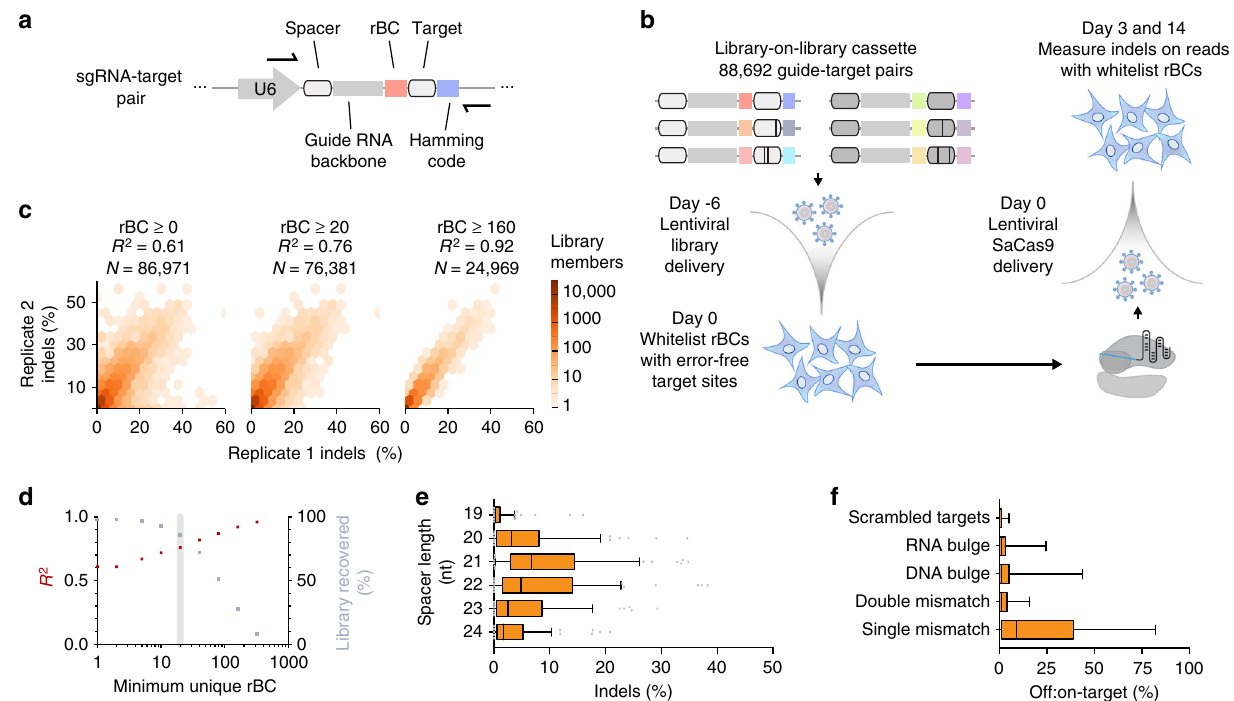
Fig. 1 Pairwise library screen of SaCas9 genome editing speci fi city. a Schematic of the pairwise library cassette. Individual library members have variable spacer and target sequences, and each member is identi fi able by a unique 15 nt error-correcting Hamming barcode. Individual molecules of each library member are tagged with a unique randomized barcode (rBC). b Schematic of the pooled pairwise library screen work fl ow. Each guide-target pair is associated with many rBCs. The library was initially installed in HEK 293T cells by lentivirus and sequenced to generate a whitelist of rBCs associated with error-free guide-target pairs. SaCas9 was then delivered by lentivirus. After 3 and 14 days, the library was sequenced to measure Cas9-mediated indels. c Reproducibility of a pairwise library screen increases if a greater number of whitelist rBCs is required for each library member. Heat color represents the number of library members in that hexagonal bin, while white area represents 0 library members. d The fraction of recovered library members decreases as a greater number of rBCs is required. All downstream analyses were performed with a minimum of 20 unique whitelist rBCs for each library member (grey). e On-target indel ef fi ciency on Day 3 for SaCas9 guide-target pairs, binned by spacer length. ( n = 653 guide-target pairs). f Comparison of SaCas9 activity across categories of target sites. The scrambled targets are negative controls ( n = 47,374 guide-target pairs). c through f use data from Day 3 post- SaCas9 delivery. Boxes in e and f denote median and interquartile range (IQR), and whiskers extend to the 10th and 90th